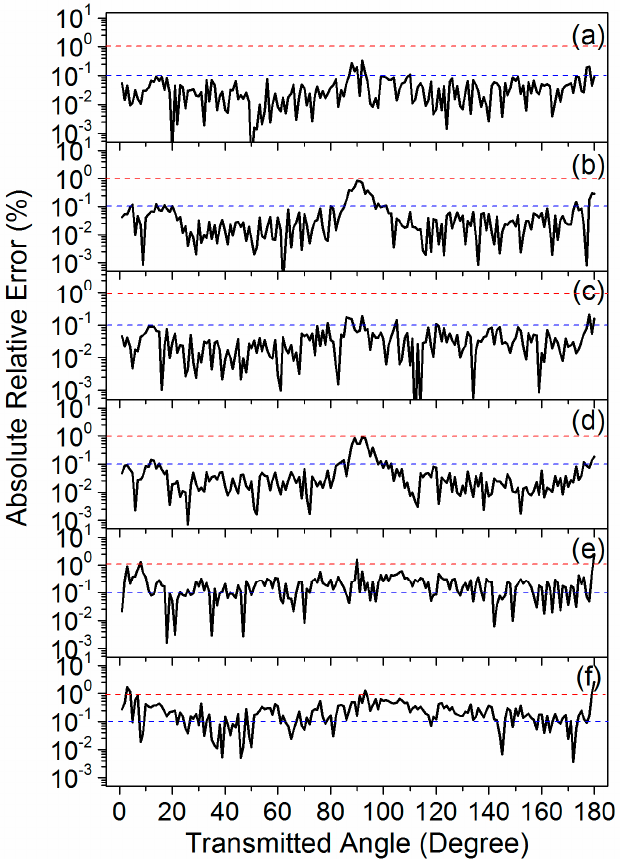
Figure 5. Absolute relative error of Markov chain angular distribution predictions compared to Monte Carlo, with OD discretization scheme 1. Panel ( a ). Phase function 1, OD = 2; Panel ( b ). Phase function 1, OD = 5; Panel ( c ). Phase function 2, OD = 2; Panel ( d ). Phase function 2, OD = 5; Panel ( e ). Phase function 3, OD = 2; Panel ( f ). Phase function 3, OD = 5. Red dash lines indicate an error threshold of 1.0%, and blue dashed lines indicate a threshold of 0.1%.